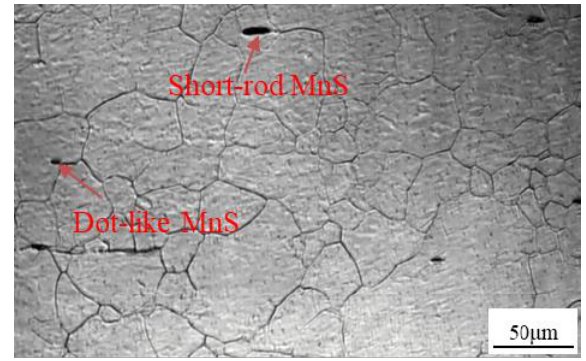
Figure 1. Original metallographic structure of the Nb-V-Ti free-cutting steel.